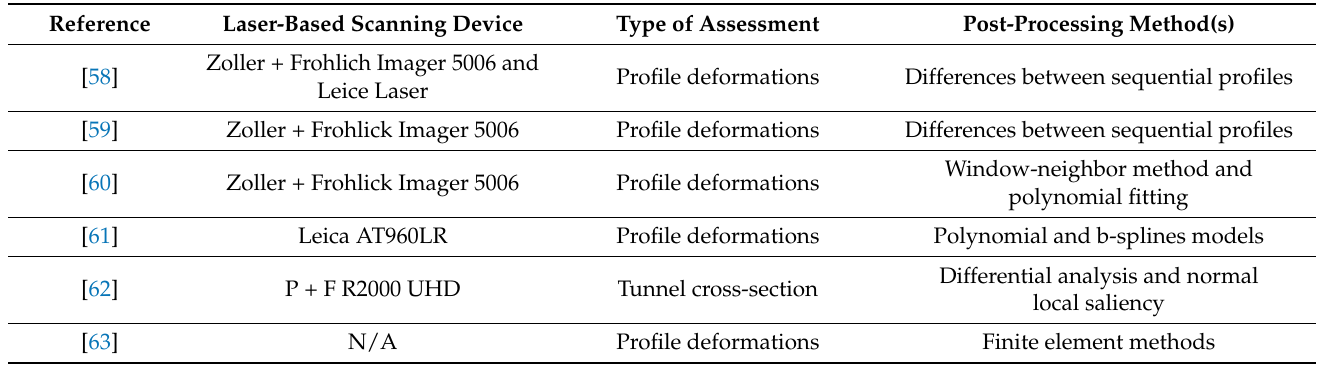
Table 4. A comprehensive summary of LiDAR-based SHM for arched